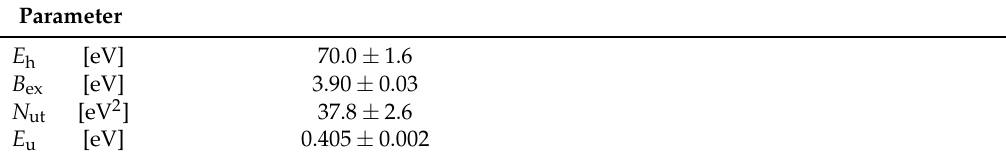
Table 3. The values of the dispersion